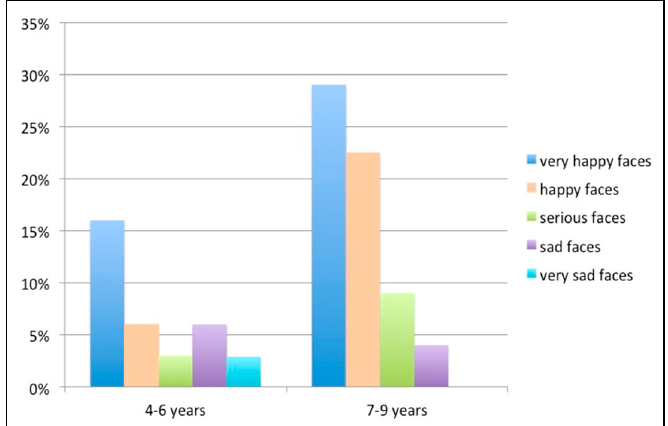
Figure 3. Bar chart of the results referring to the age of the patient.